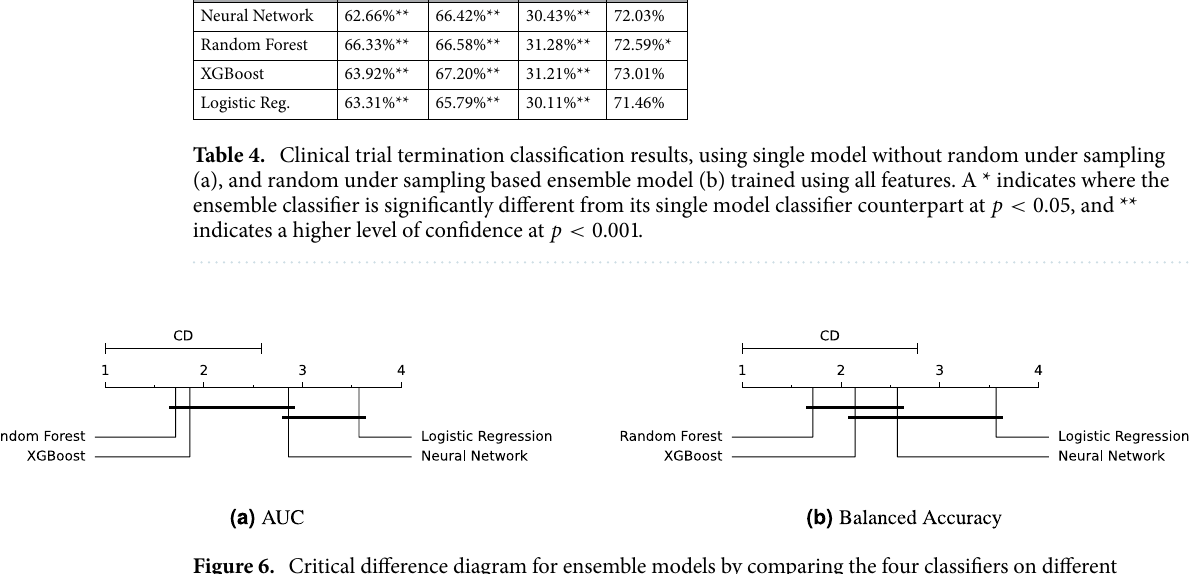
Figure 6. Critical difference diagram for ensemble models by comparing the four classifiers on different combinations of features; ( a ) AUC scores with α = 0.1 , the critical difference is 1.58; ( b ) Balanced Accuracy with α = 0.5 , the critical difference is 1.77. Groups of classifiers that are not significantly different are